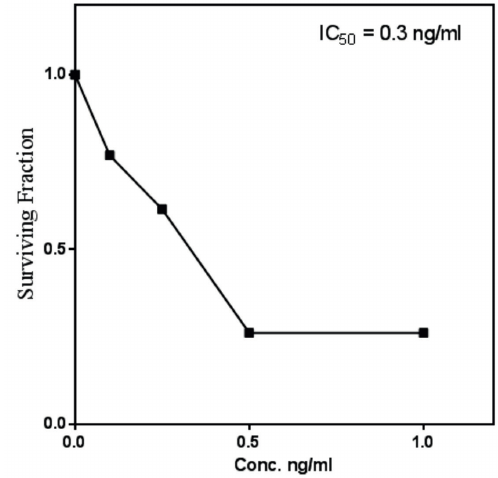
Fig. 4. Antiproliferative activity of extracted Taxol from A. terreus towards MCF-7 breast cell lines in vitro